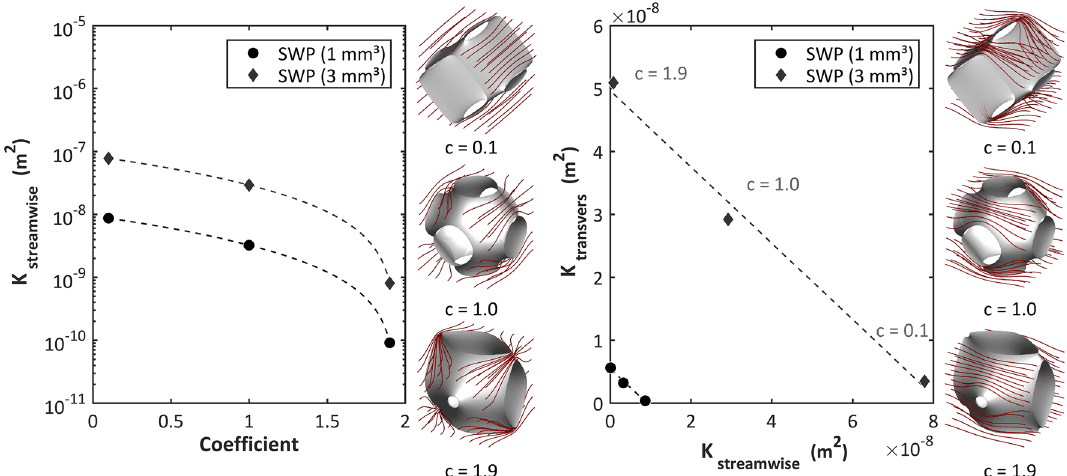
Figure 6. Simulated SWP permeability data: ( a ) Streamwise permeability depending on the cosine. Dashed lines show quadratic correlation curves between the value of the coefficient ‘c’ of the implicit function term and the consequent permeability. Images next to graph give an impression of the undeformed (c = 1.0) and deformed SWP elements. Streamlines indicate streamwise flow direction. ( b ) Relation between streamwise and transverse permeability. Dashed lines show linear correlation curves. Images next to graph give an impression of the undeformed (c = 1.0) and deformed SWP elements. Streamlines indicate transverse flow